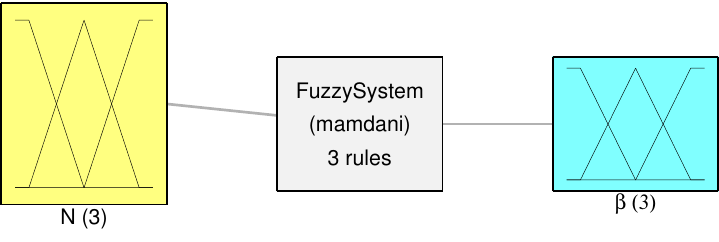
Figure 5. Architecture of Fuzzy Inference System to adjust β .